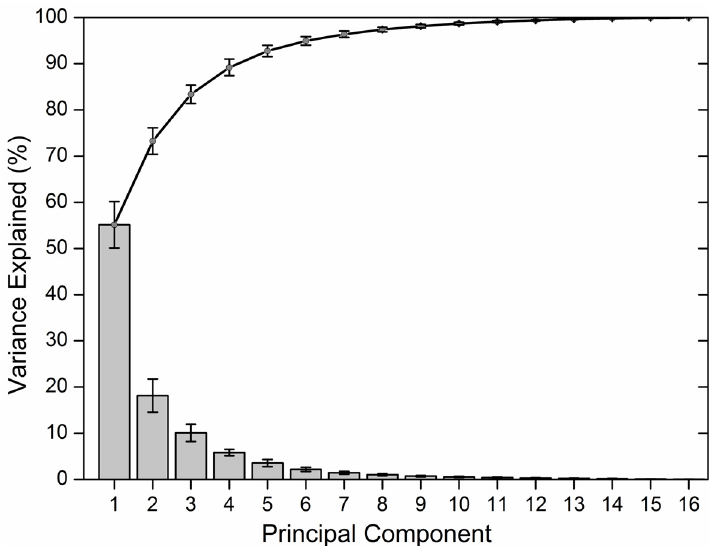
Fig 2. A Pareto chart for the variance explained by the movement dataset of joint angles. The bars illustrate the variance explained by each principal component (PC) from the PCA, and the line illustrates the cumulative variance explained by the retaining PCs. Error bars indicate standard deviations across